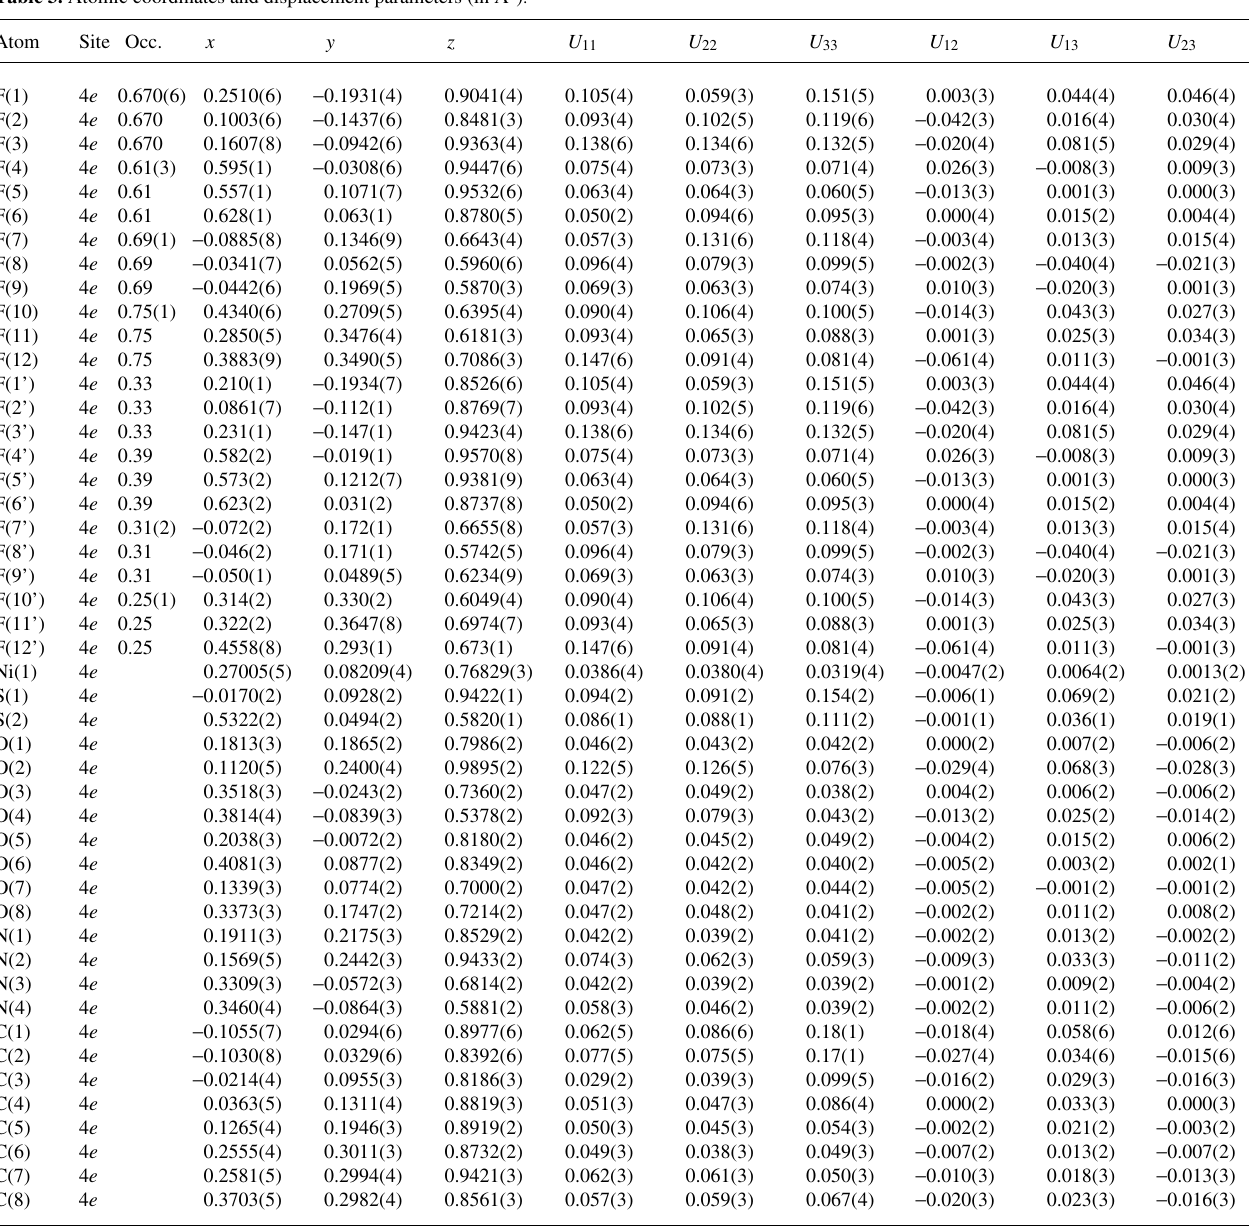
Table 3. Atomic coordinates and displacement parameters (in Å 2 ) .